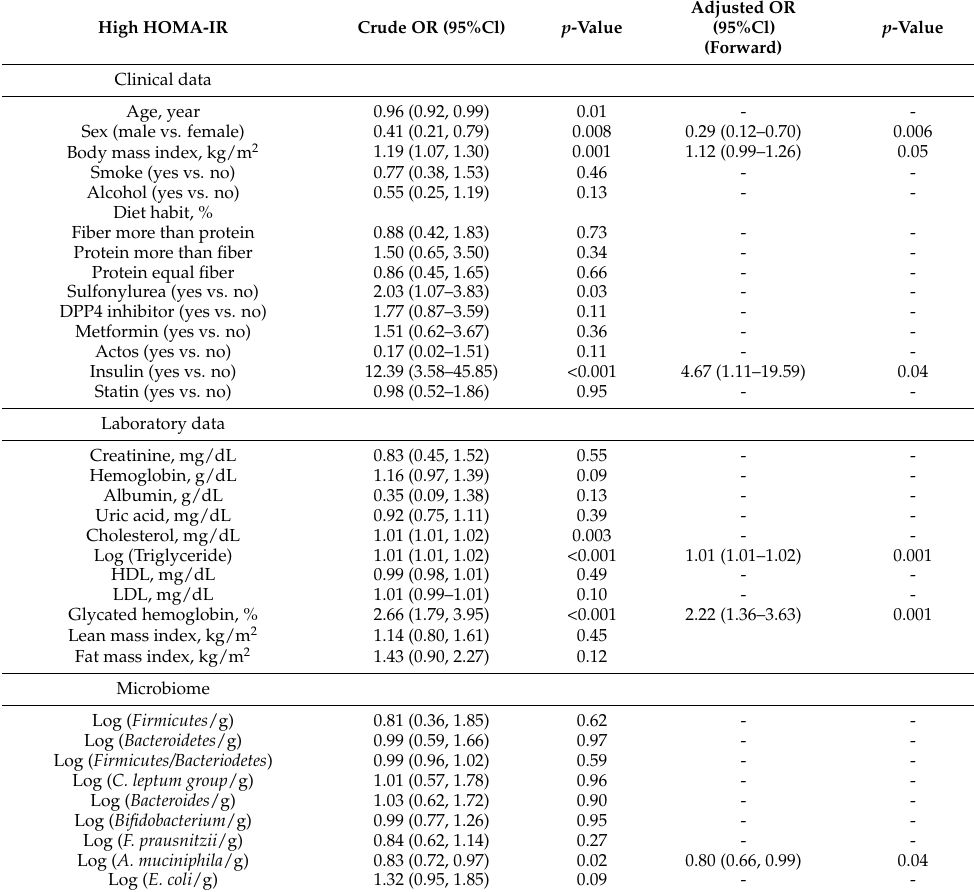
Table 3. Logistic regression of determinants of high HOMA-IR ( ≥ median). High HOMA-IR Crude OR (95%Cl) p